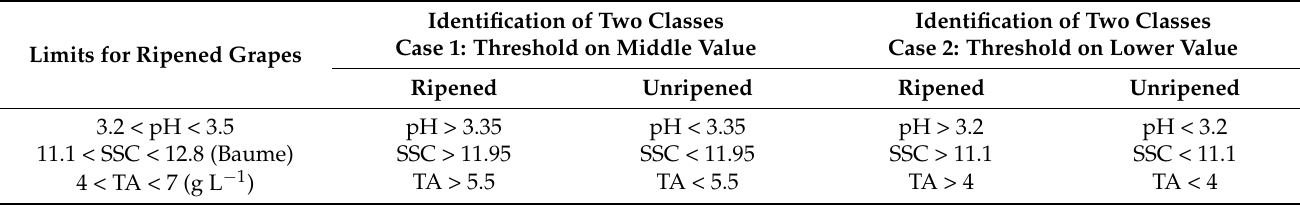
Table 4. Indicative limits of basic chemical attributes SSC, TA, and pH in ripened wine grapes [3], and identification of two classes (ripened and unripened) based on a selected threshold (middle value and lower value).